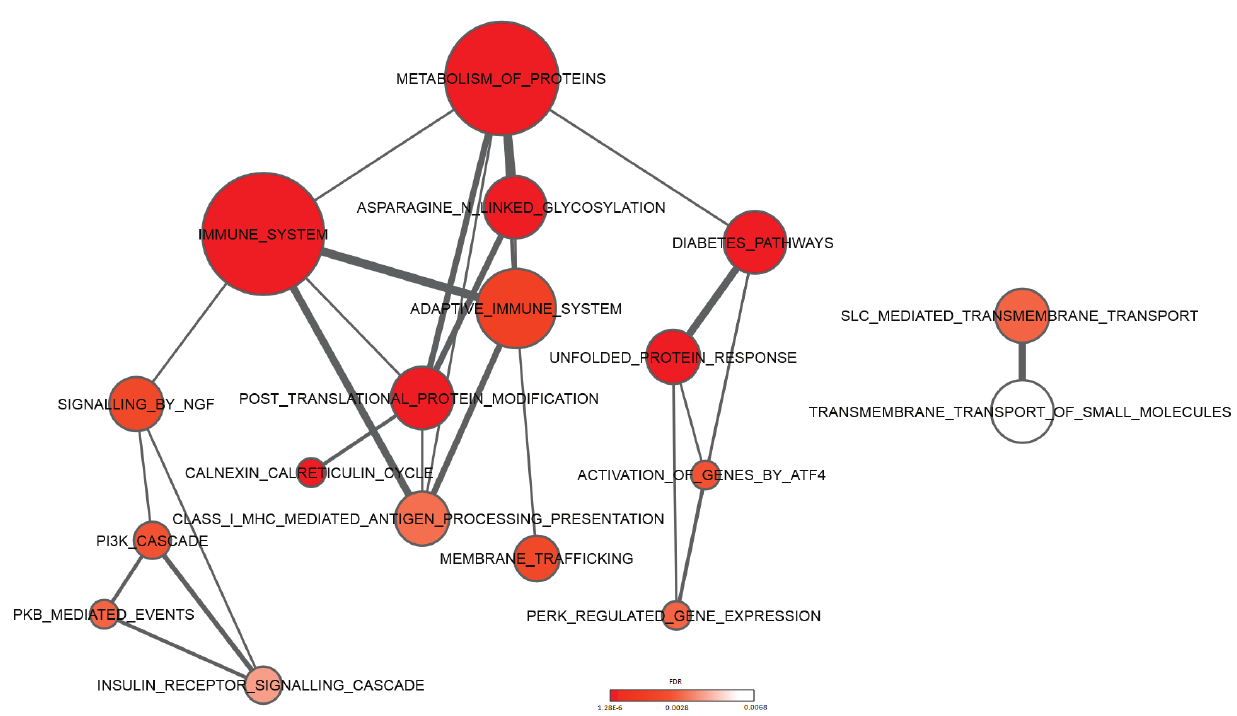
Figure 5. Pathways enriched among upregulated UPR genes. The network of pathways with overrepresentation of upregulated UPR genes are shown. Node size represents number of genes in each pathway and connecting line size represents number of genes shared between two pathways. Colour coding from white to red indicates increasing statistical significance. Pathways were derived from the Reactome